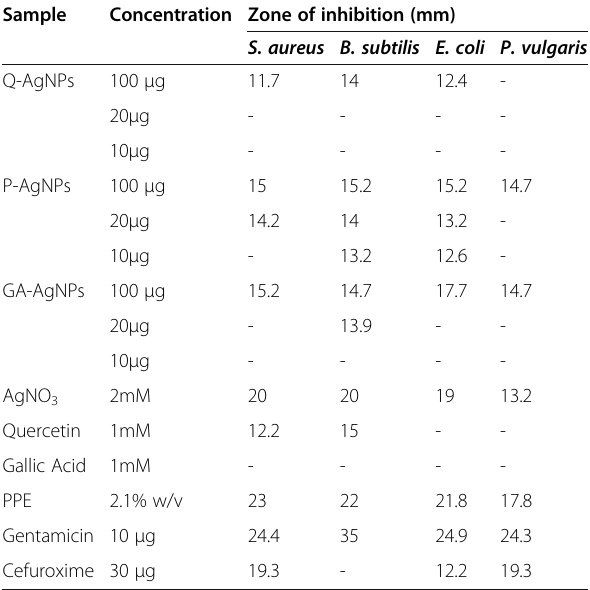
Table 2 Antibacterial activity of biosynthesized AgNPs Sample Concentration Zone of inhibition (mm)